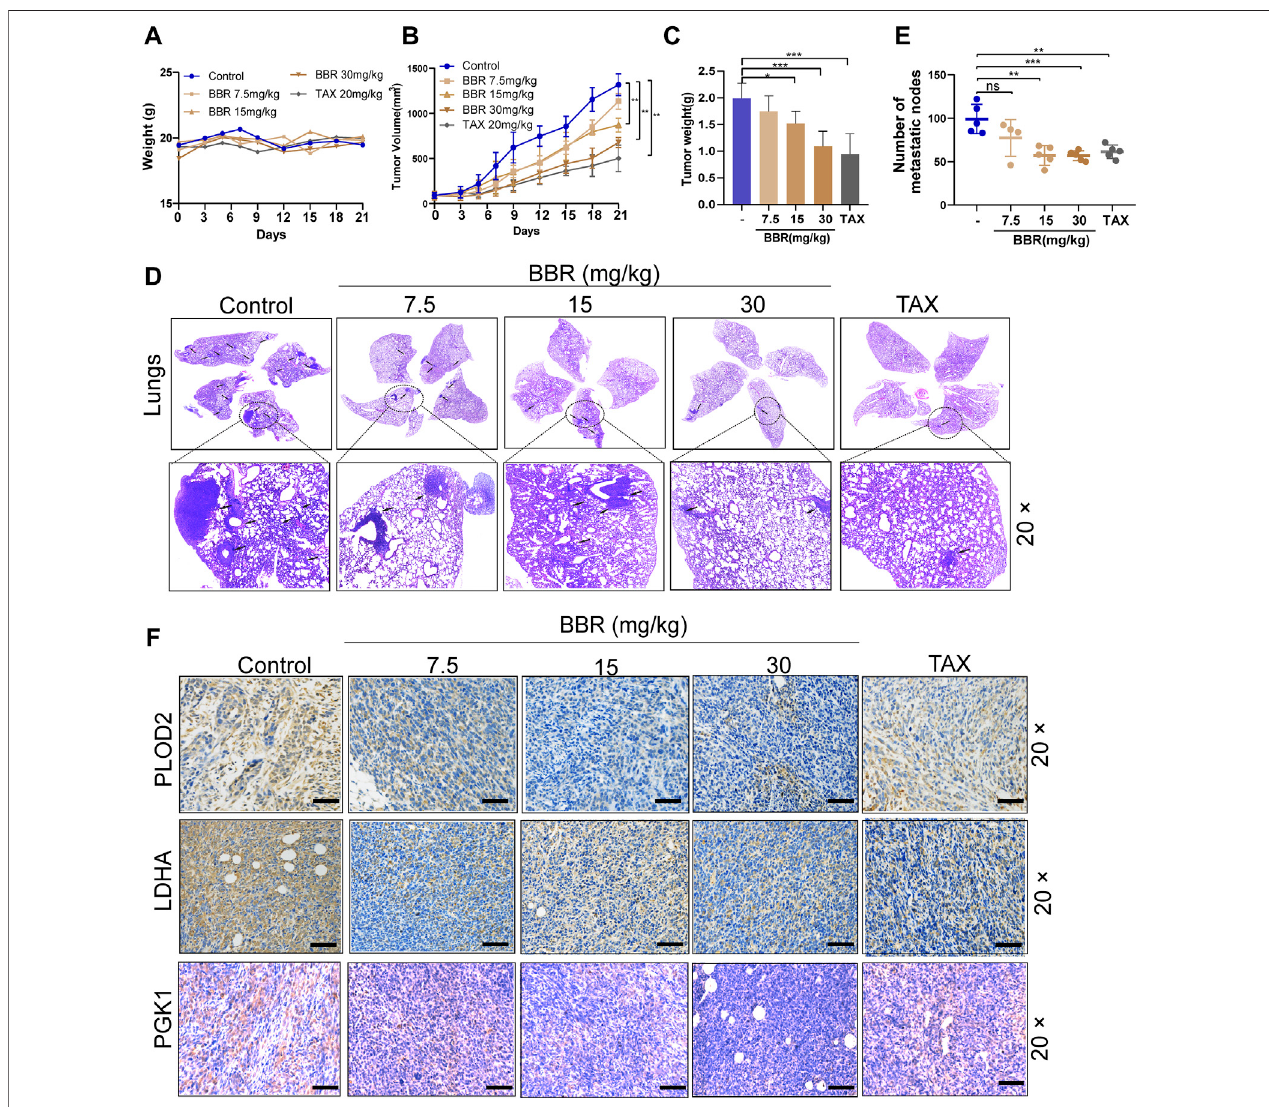
FIGURE6| BerberineattenuatesTNBCgrowthandinhibitsthemetastasisintheorthotopicmammaryfatbreasttumormodel. (A) Thealterationofbodyweightsin different treatment groups. Error bars were the means ± SD, n = 5 or 6. (B – C) Tumor volume curves of tumor growth and tumor weight after orthotopic injection of the 4T1 cells. Berberine (15 mg/kg, 30 mg/kg) administration inhibited the growth of 4T1 breast tumors, and TAX (20 mg/kg) was used as the positive control. Error bars were the mean ± SD. n = 5 or 6 per group, p < 0.01. (D) Representative pictures of the lungs were detected by H&E staining. Arrows indicate metastatic colonization. (E) Quanti fi cation of metastatic foci in lung was calculated, n = 5 or 6 per group. p < 0.01, p < 0.001 vs. the control. (F) The LH2, LDHA, and PGK1 expression in tumors were detected by the immunohistochemistry staining, respectively. 20 × scale bars, 100 μ m.